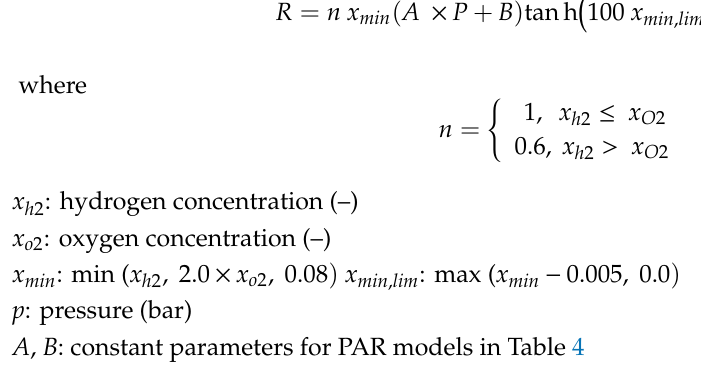
Table 4. Values of constant parameters for AREVA